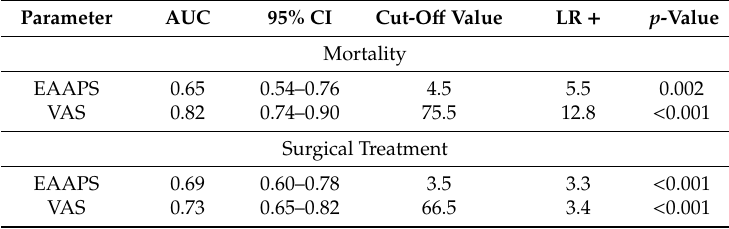
Table 4. Predictive Validity: The ability of the visual analogue scale (VAS) and the Equine Acute Abdominal Pain Scale (EAAPS) to predict mortality or surgical treatment in the horses presented with colic. Presented are; the area under the curve (AUC) of receiver operating characteristic curve with 95% confidence intervals (95% CI), the p -value and the cut-o ff values at the highest likelihood ratios of a positive test (LR + ).